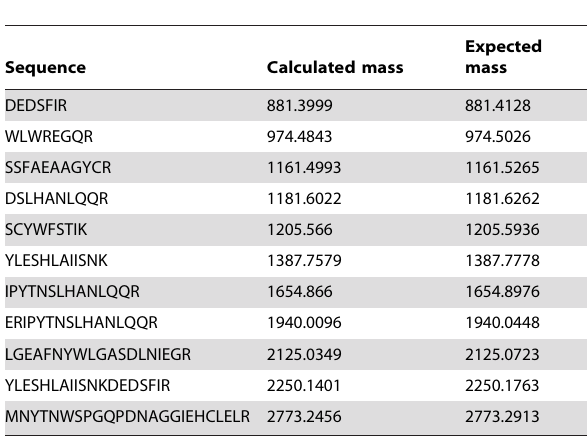
(Table 2). Within 2–72 hours, crystals formed free-floating and strongly attached to the bottom of the glass vial from a clear, transparent solution (Figure 7A and Figure 8) . In contrast to GFP and GFP-perlucin, the same concentrations of FITC-labelled Concanavalin A, a lectin control protein, did not delay or inhibit calcium carbonate precipitation (see Table 2 for pH values).